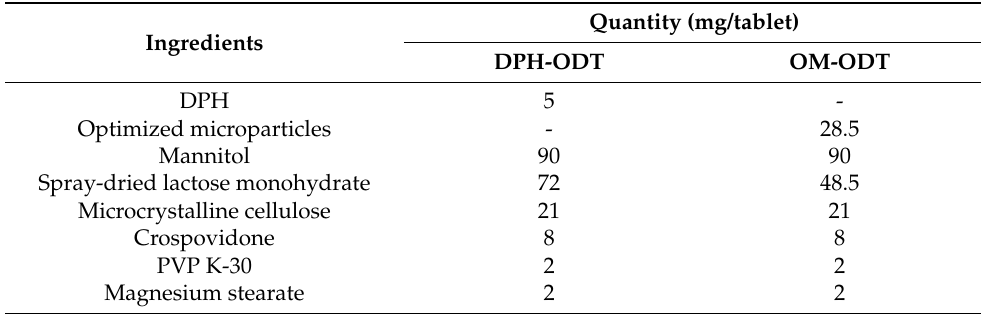
Table 1. Formulation of ODT containing DPH and optimized